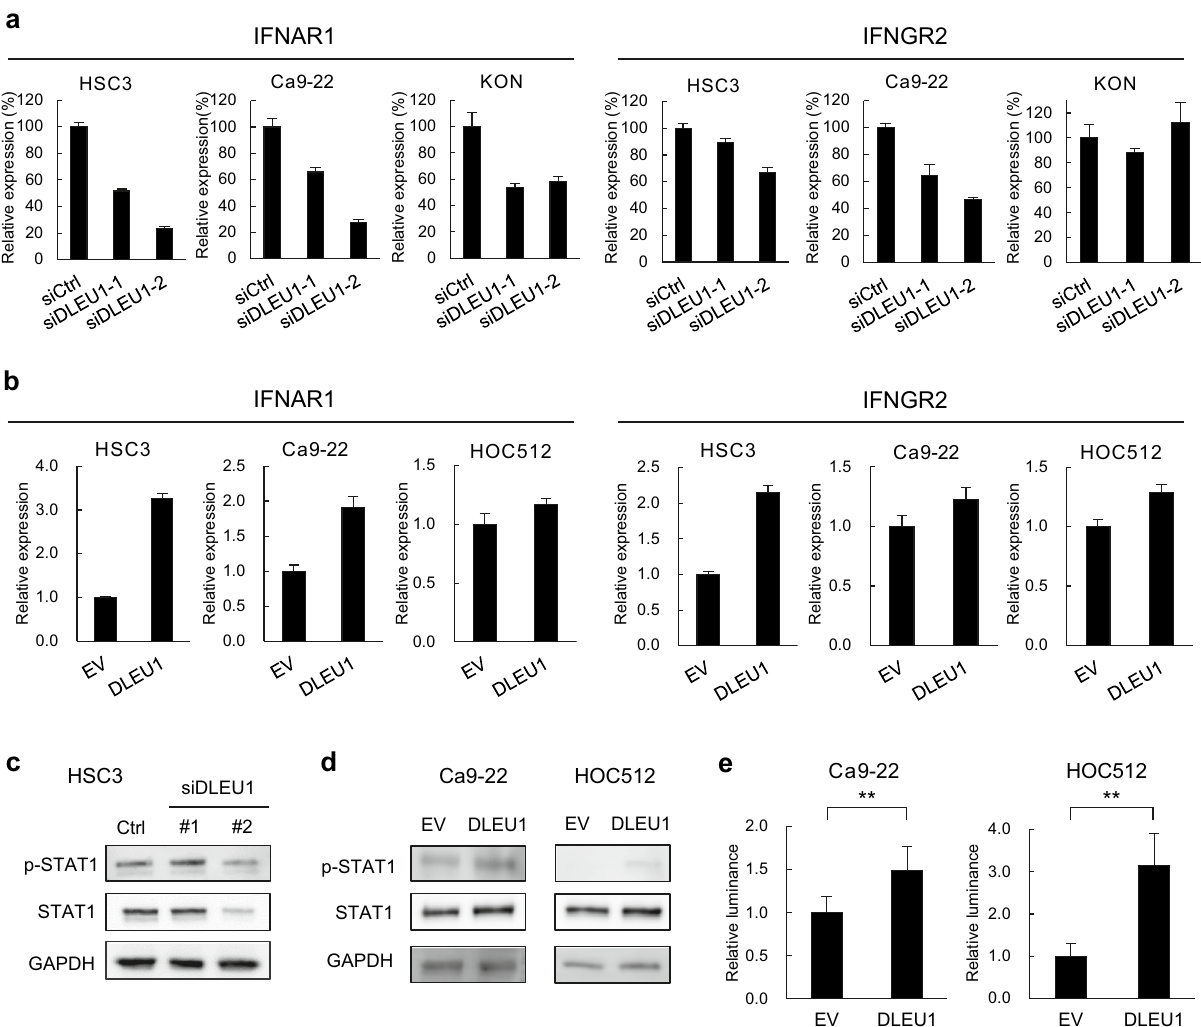
Figure 4. DLEU1 upregulates interferon receptor genes and activates JAK-STAT signaling in OSCC cells. ( a ) qRT-PCR analysis of IFNAR1 (left) and IFNGR2 (right) in OSCC cell lines transfected with the indicated siRNAs. ( b ) qRT-PCR analysis of IFNAR1 (left) and IFNGR2 (right) in OSCC cell lines transfected with the indicated vectors. ( c , d ) Western blot analysis of total and phosphorylated STAT1 in the indicated OSCC cells with DLEU1 knockdown ( c ) or ectopic DLEU1 expression ( d ). ( e ) Results of ISRE reporter assays in OSCC cells transfected with the indicated vectors. ** P <